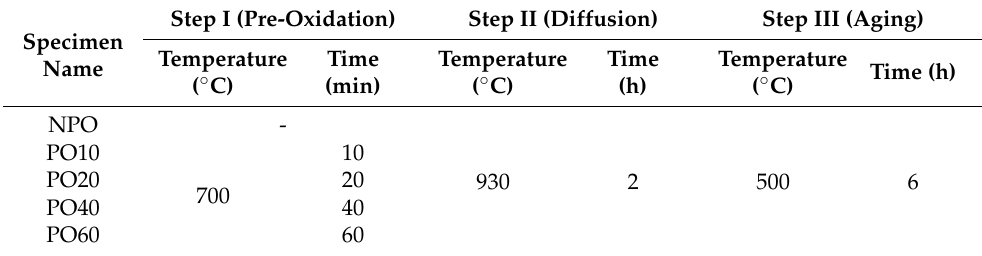
Table 3. Heat-treatment